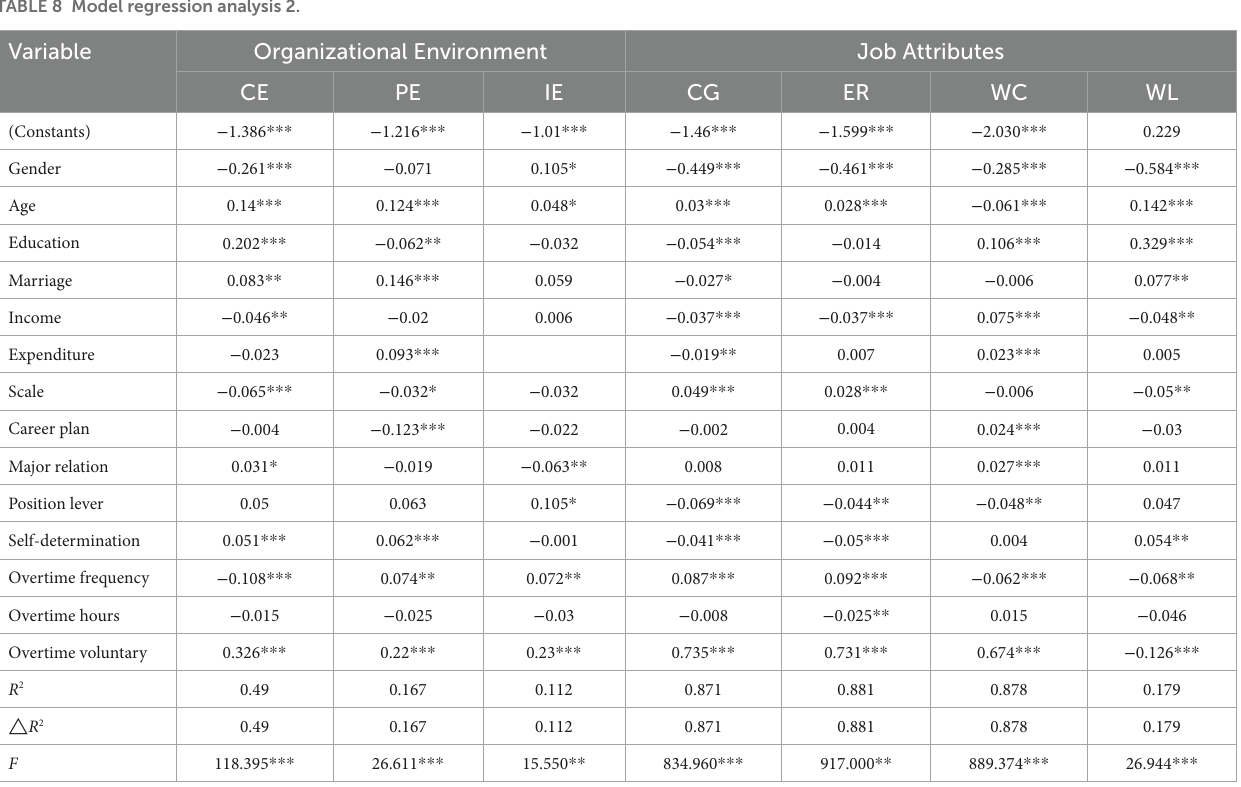
TABLE 8 Model regression analysis